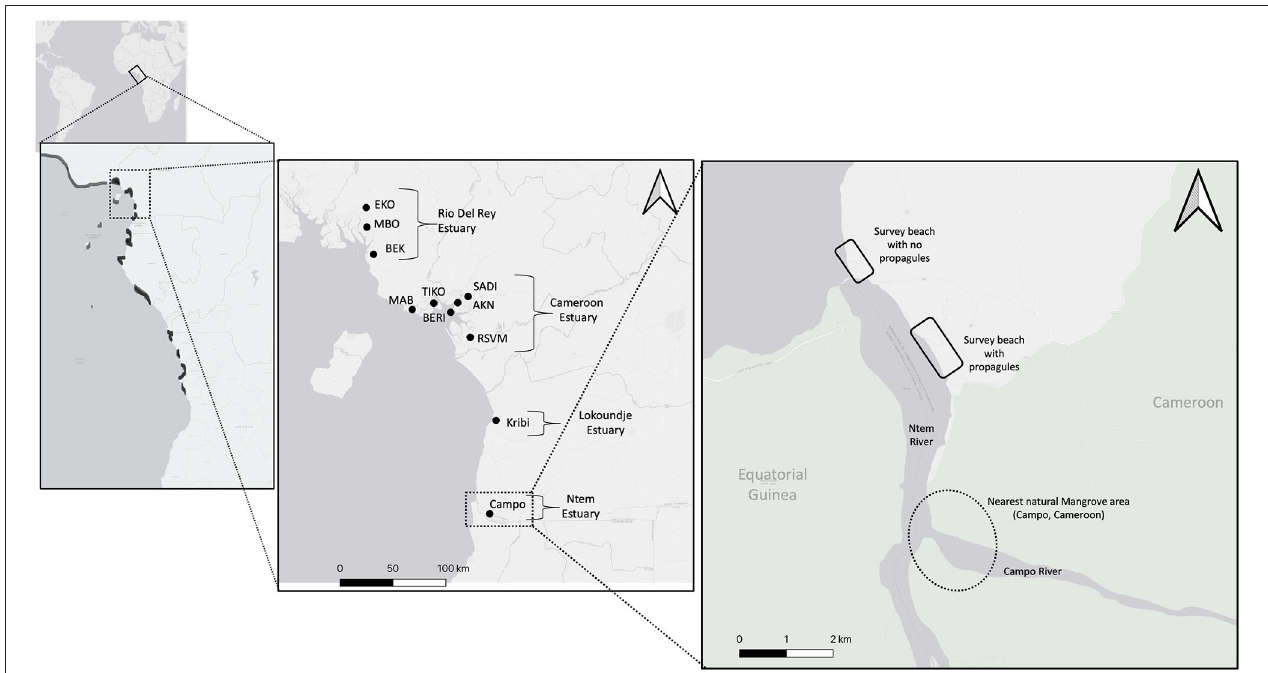
FIGURE 1 | Map of the Cameroonian Coastline, showing our extensive sampling from North to south at all 4 mangrove estuaries (from north to south: Rio Del Rey, Cameroon Estuary, Lokoundje, and Ntem). On the left the black markings along the coastline show the mangrove estuaries. Zoomed at the Ntem Estuaries to show the survey beaches, which were ∼ 2km apart and about a square kilometer area each. Base map generated from ESRI Gray (light), CRS:3857 in QGIS version 3.10.0-A